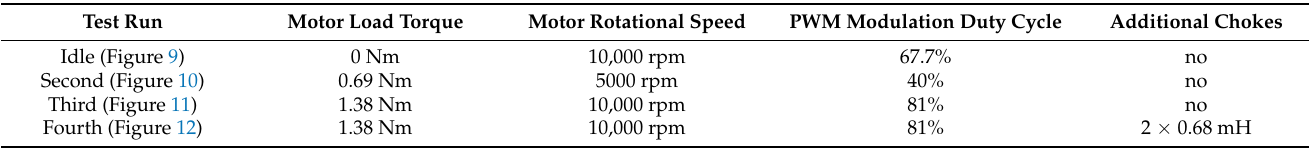
Table 1. Conditions of the tests conducted to measure the harmonic components of the current drawn by the drive system under testing. PWM: pulse width